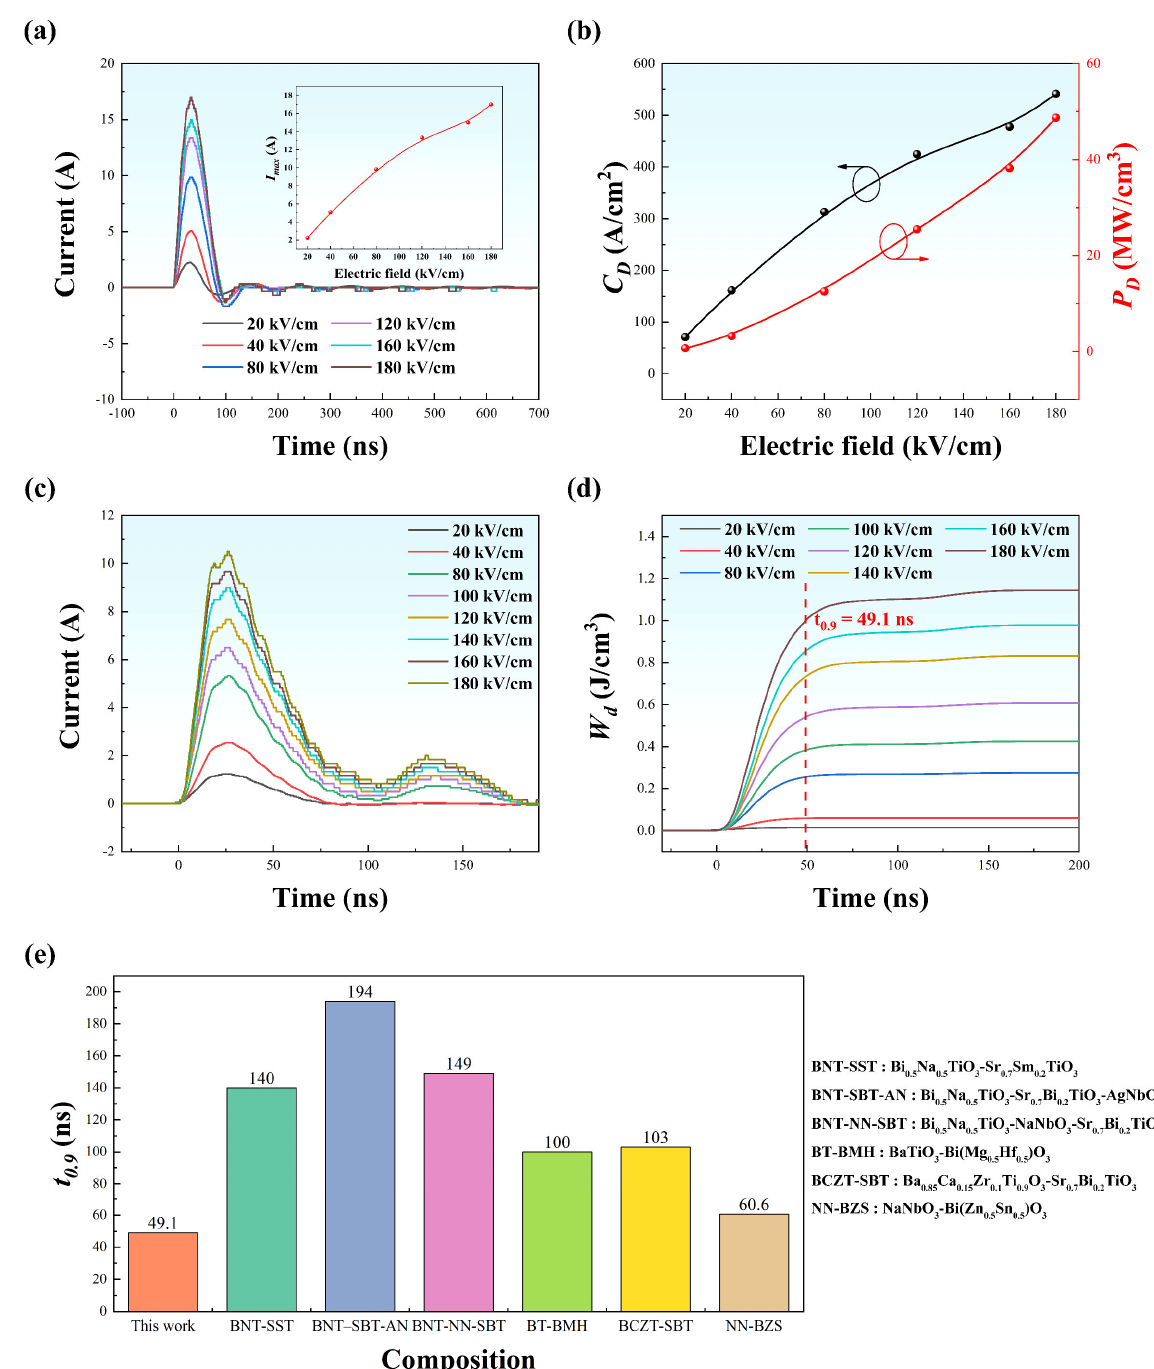
Figure 8. ( a ) Undamped discharge waveform, and ( b ) variation of C D , P D at various electric fields for x = 0.15 sample; ( c ) overdamped discharge waveform; ( d ) time-dependent discharge energy density at various electric fields for x = 0.15 sample; ( e ) comparison of t 0.9 for the sample of x = 0.15 and other lead ‐ free ceramics recently reported.